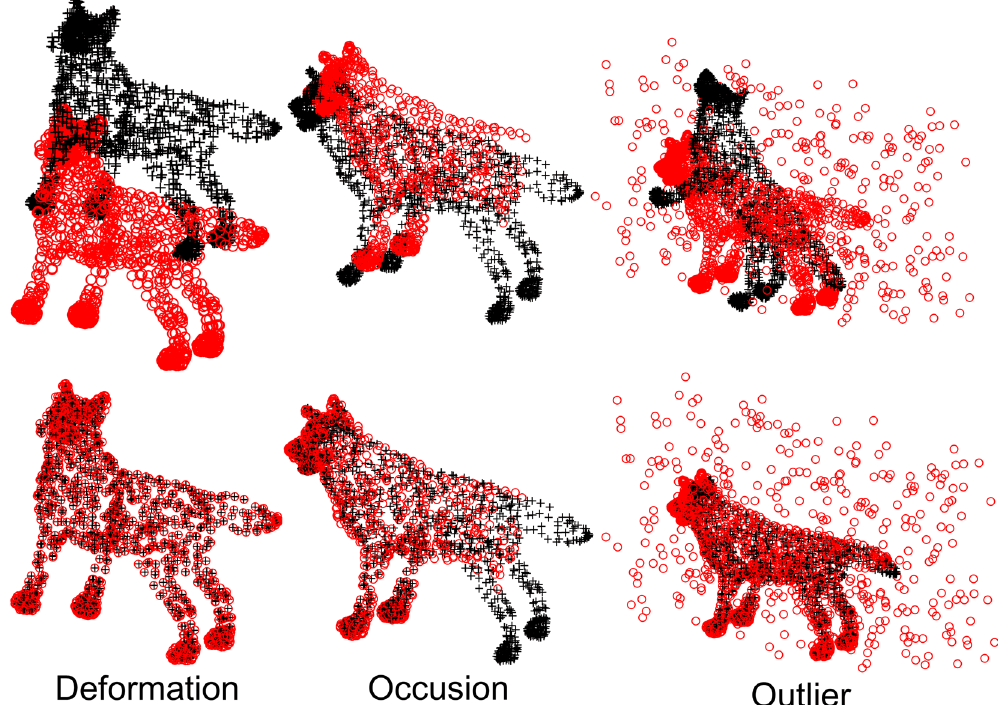
Figure 13. Preformation of DSMM on 3D wolf shapes with deformation, occlusion and outliers. We align the template points (black “ + ”) to the target points (red “o”) For each sample, the figures in the top row show template points and the target data before registration, and the figures in bottom show the registration